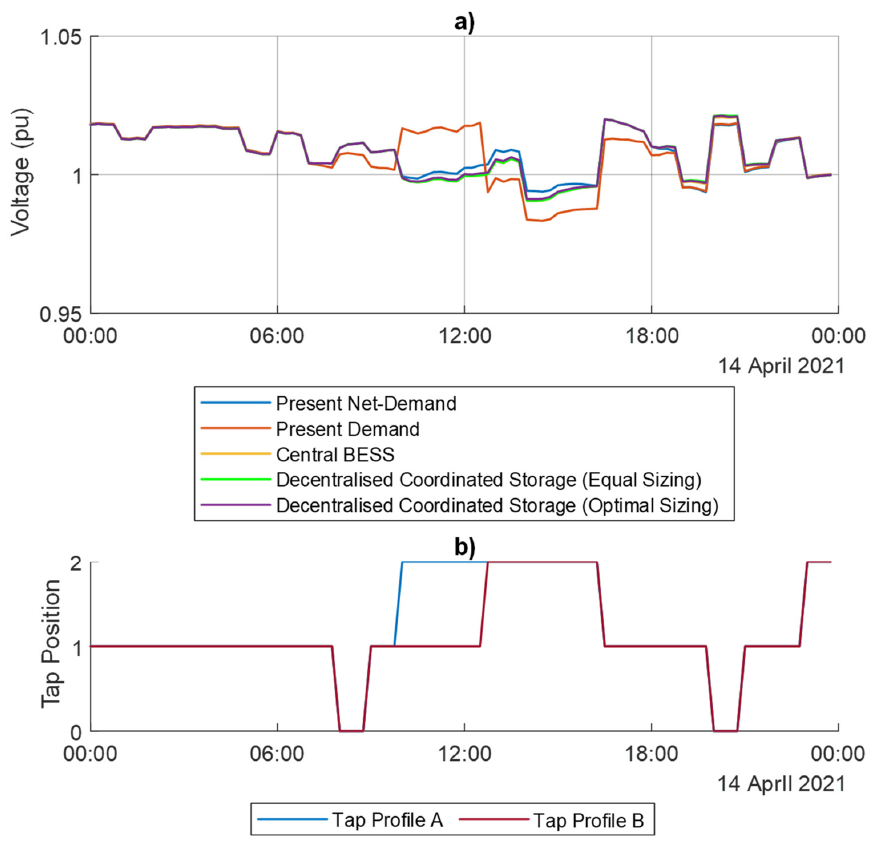
Figure 13. ( a ) Simulated voltage profiles at the 11 kV side of the Xewkija DC transformer. ( b ) Tap positions for simulations. Profile B is for the Case 2 (Demand) while Profile A was common to the other four scenarios.